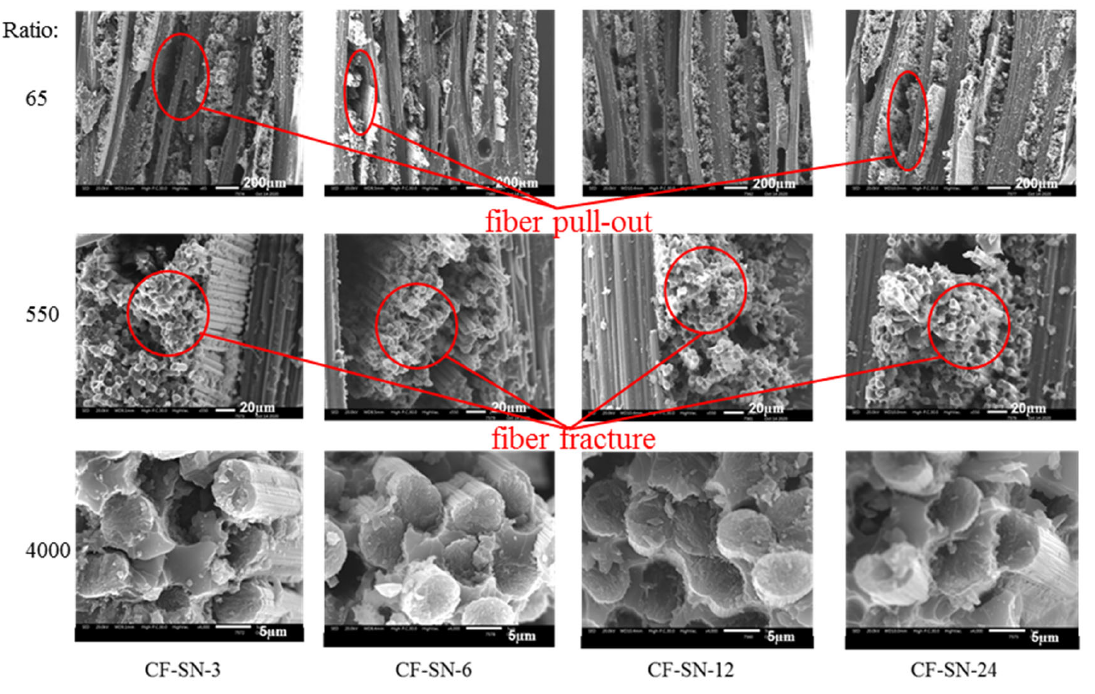
Figure 13. SEM images of the fracture position of the specimen group with an equal size; no significant difference in the failure modes for the specimens of this group. Failure modes present mostly in fiber fracture and a small part of fiber pull-out and delamination, with a relatively smooth fiber fracture face.